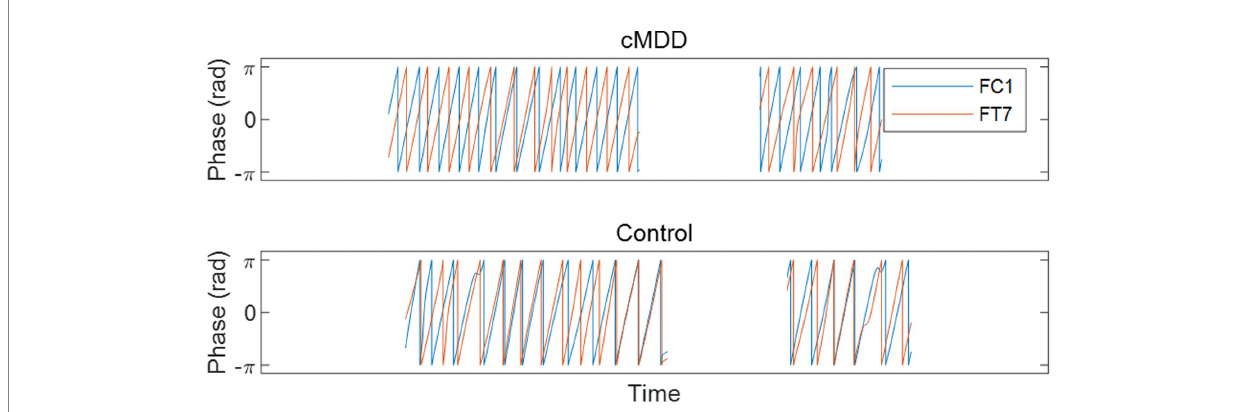
FIGURE 4 An example of the disruption of spatial correlation between amplitude fluctuations of theta oscillations in an eyes-closed patient with major depressive disorder. A graph is drawn only when the eyes are closed. Misaligned oscillation phases indicate the disruption of spatial